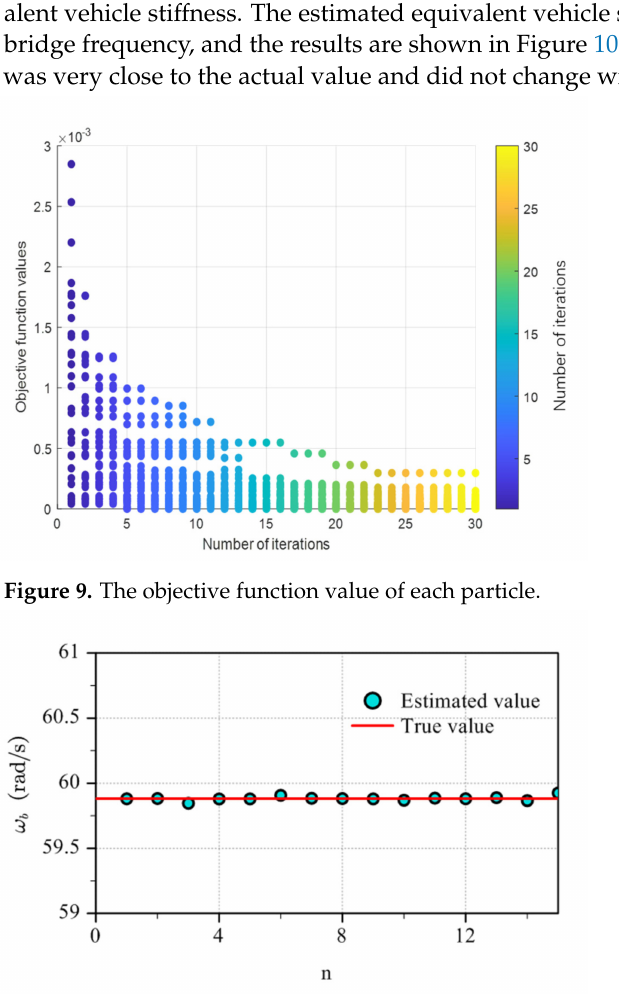
Figure 10. Estimation of bridge frequency under different number of vehicles. After obtaining the equivalent vehicle stiffness estimate of k (cid:48) , the ratio of bridge vibration to vehicle vibration amplitude t could be calculated according to Equation